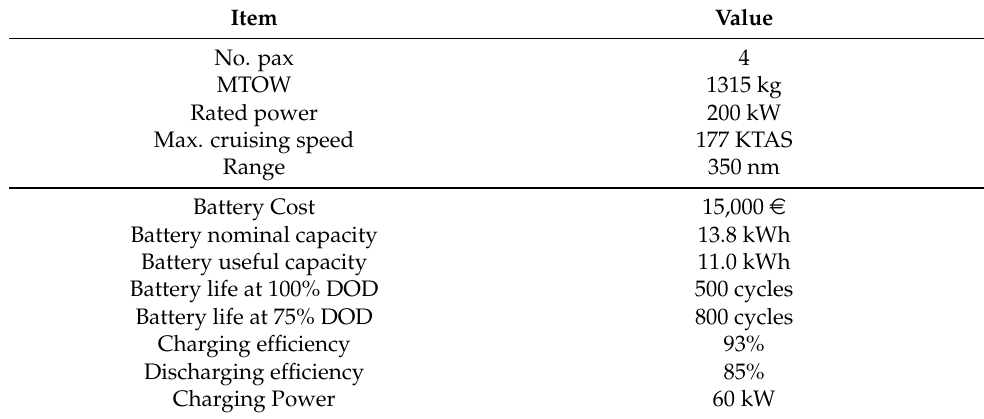
Table 5. Panthera Hybrid main